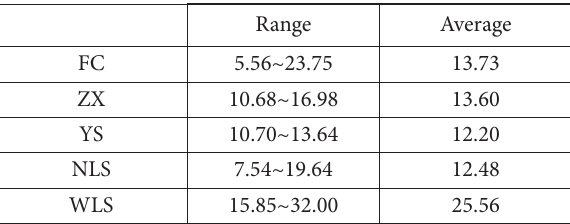
Table 6. The comprehensive scores of different zones in the aeolian sand region